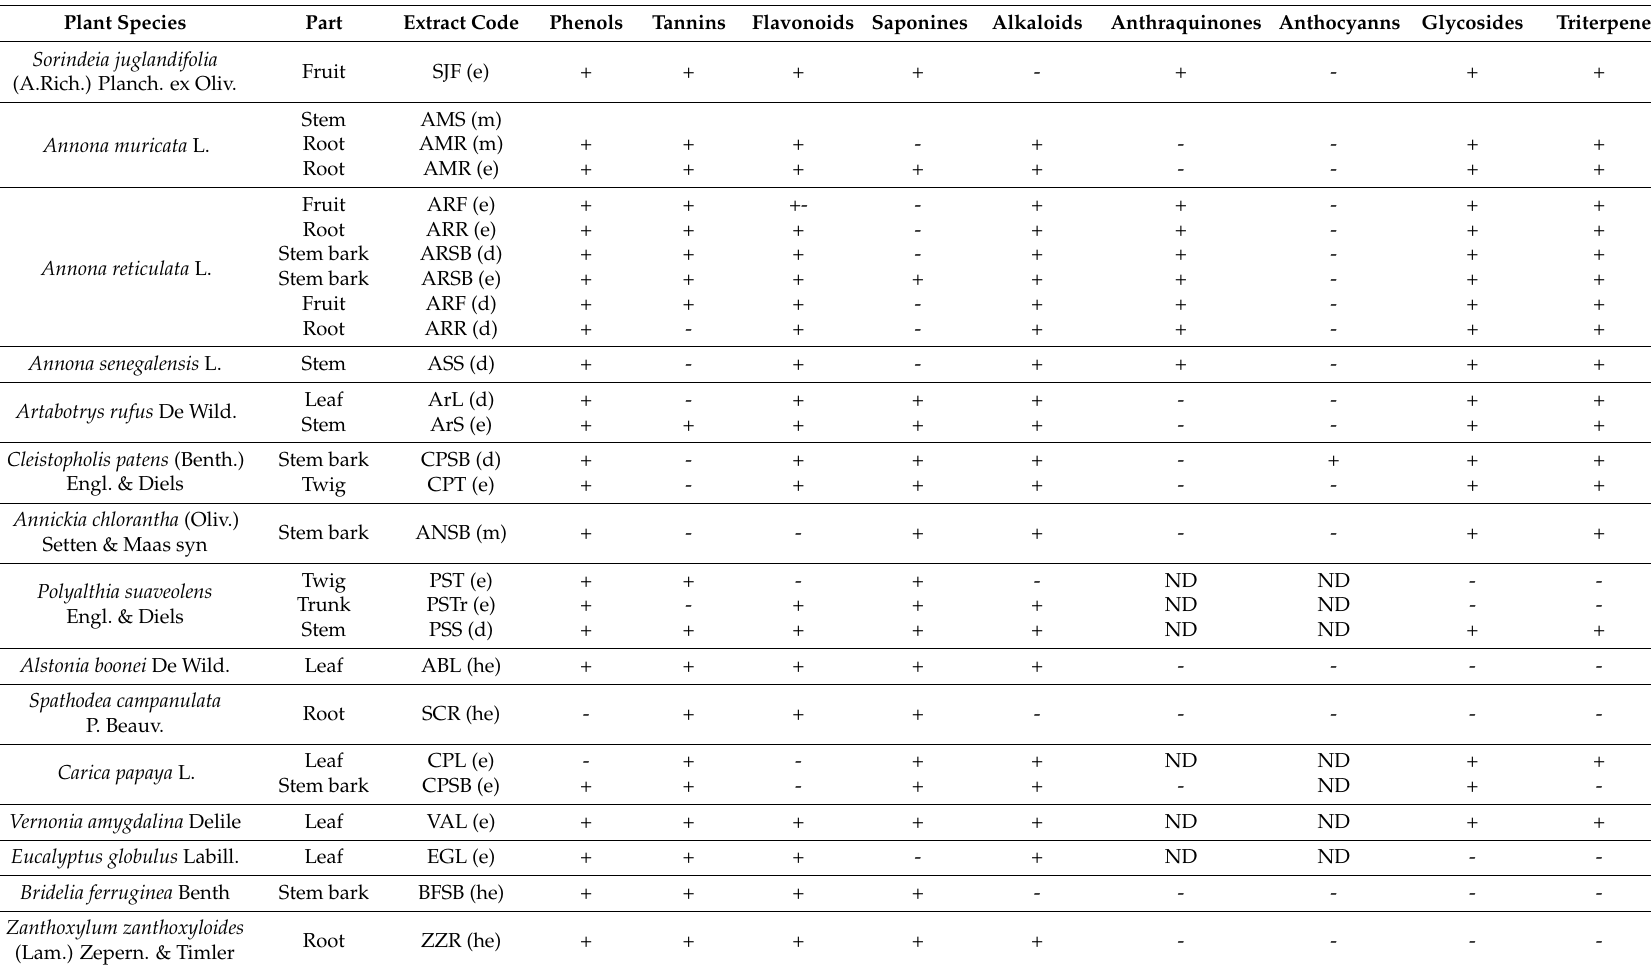
Note: + indicates presence of metabolite type; – indicates absence of metabolite